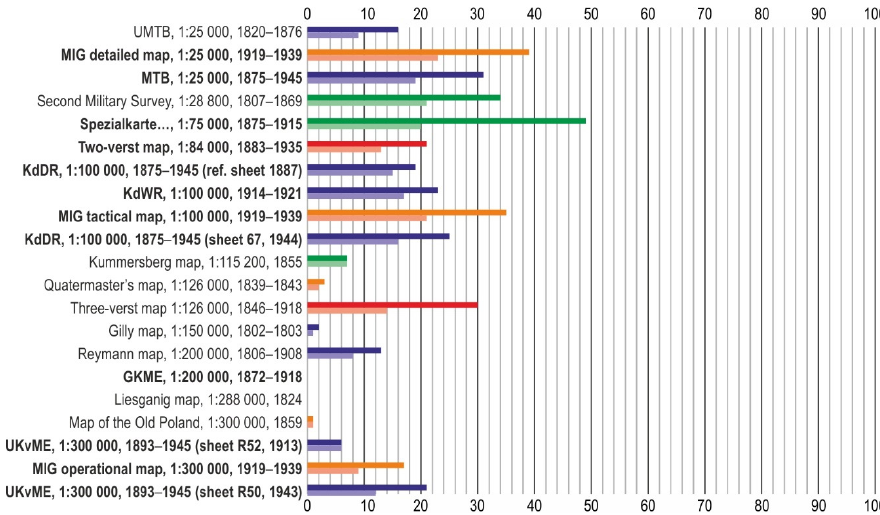
Fig. 8. Number of feature types on different maps’ key to symbols among “other features” feature class category (before and after